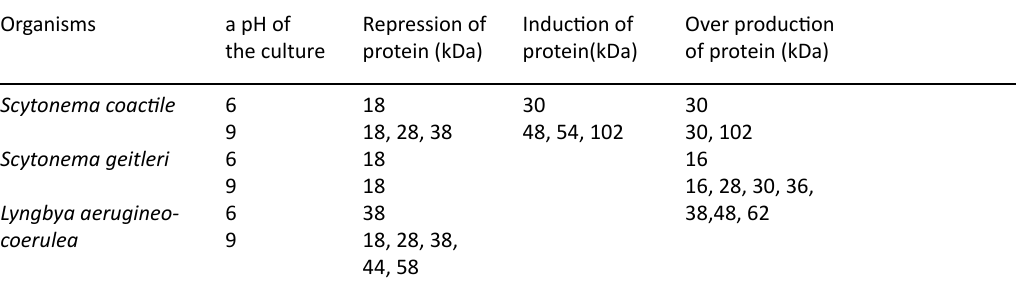
Table 1. Changes in the protein profile of three sub-aerial cyanobacteria strains, Scytonema coactile, S. geitleri and Lyngbya aerugineo-coerulea has grown at specific pH 6 and 9 under continuous illumination (2000 lux) at 28±2°C up to 15 days Organisms a pH of Repression of Induction of Over production the culture protein (kDa) protein(kDa) of protein (kDa)